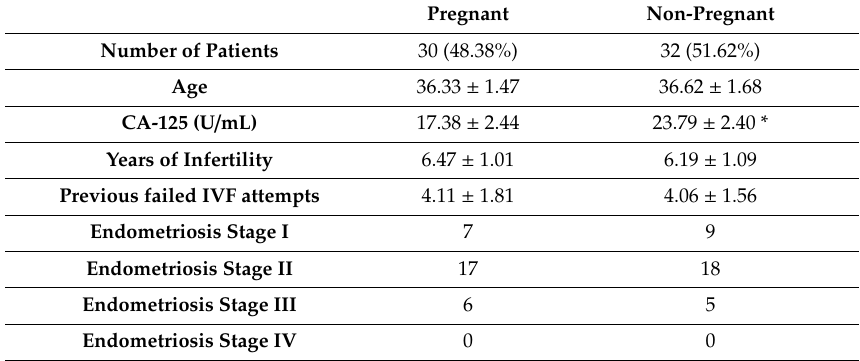
Table 3. Mean ± Standard Deviation of patients’ age, CA-125 levels, years of infertility and number of previous failed IVF attempts for pregnant and non-pregnant group diagnosed with endometriosis following